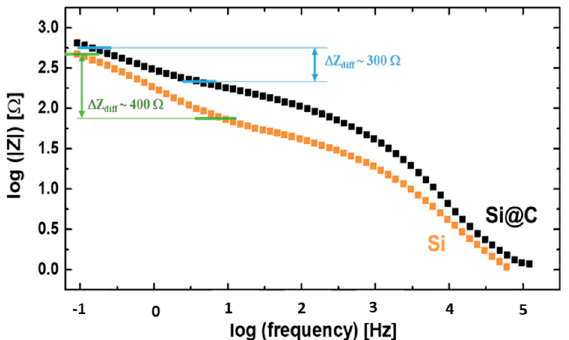
Figure 6. EIS Bode plots after 50 cycles, enlightening the diffusion impedance domains for both Si (orange square) and Si@C (black dot) materials.